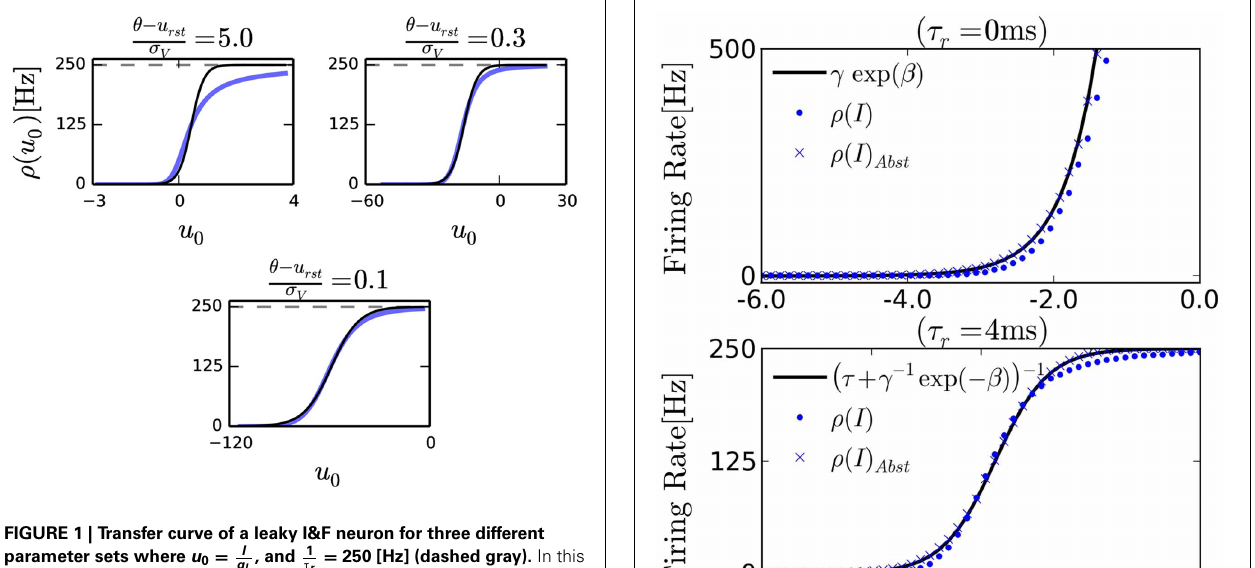
= 250 [Hz] (dashed gray). In this , and 1 τ r L . The three plots above V